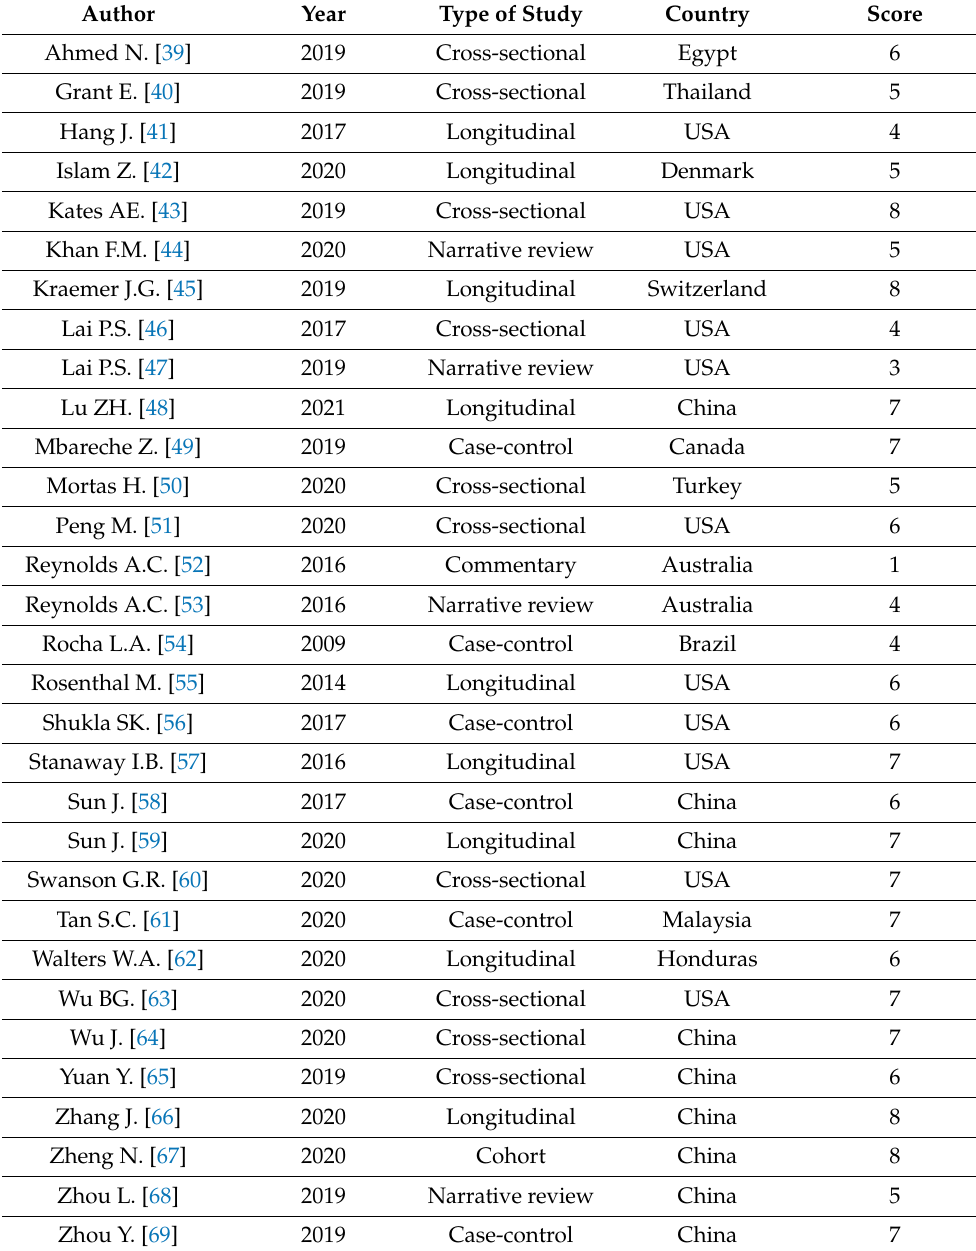
Table 2. Studies included in the systematic review in alphabetical